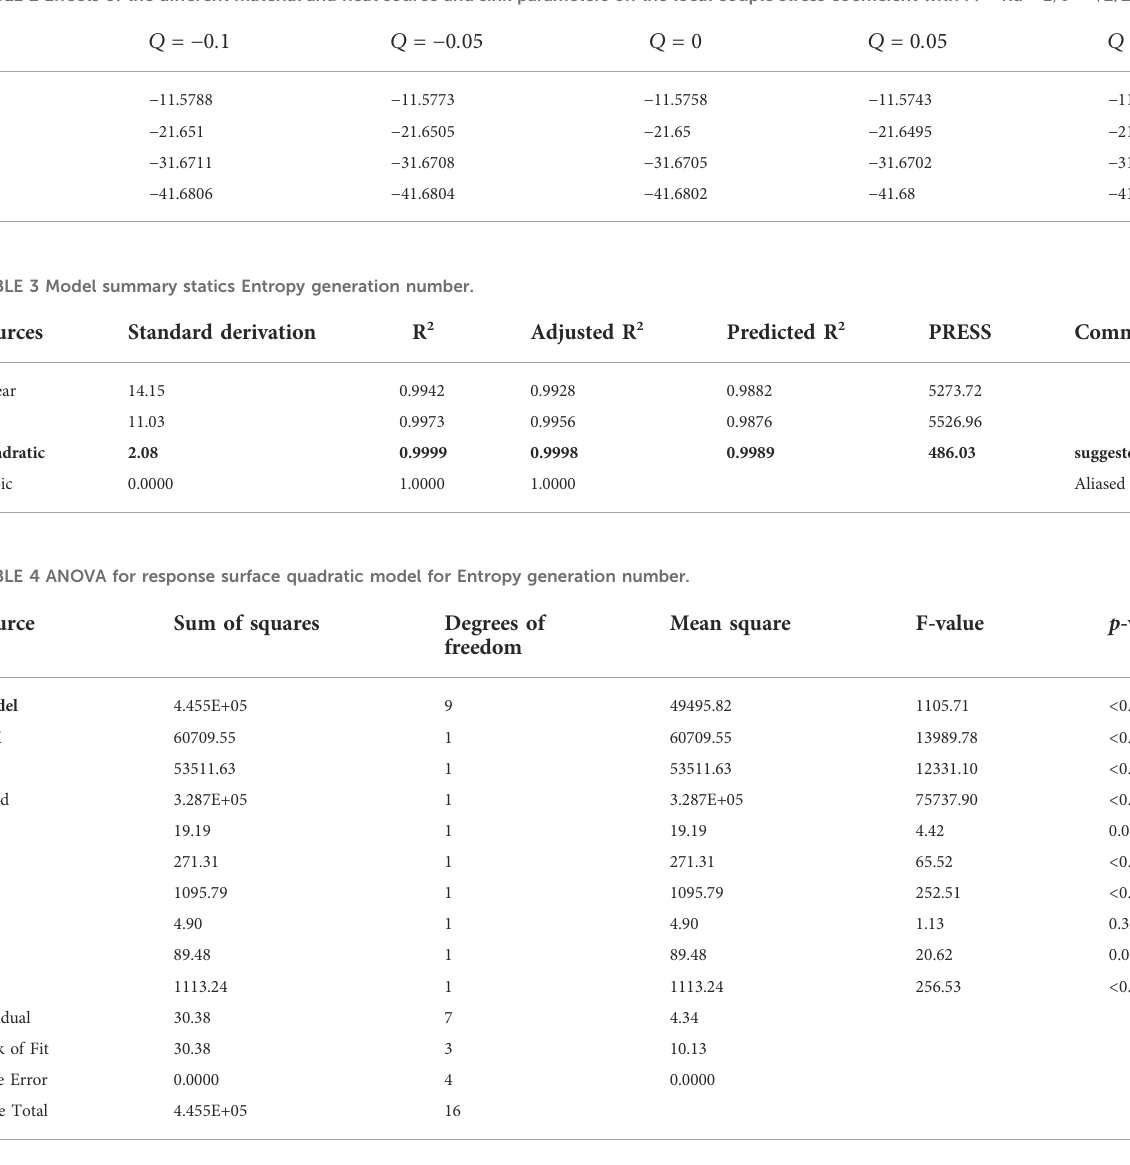
TABLE 2 Effects of the different material and heat source and sink parameters on the local couple stress coef fi cient with Pr (cid:3) Rd (cid:3) 1 , Γ (cid:3)